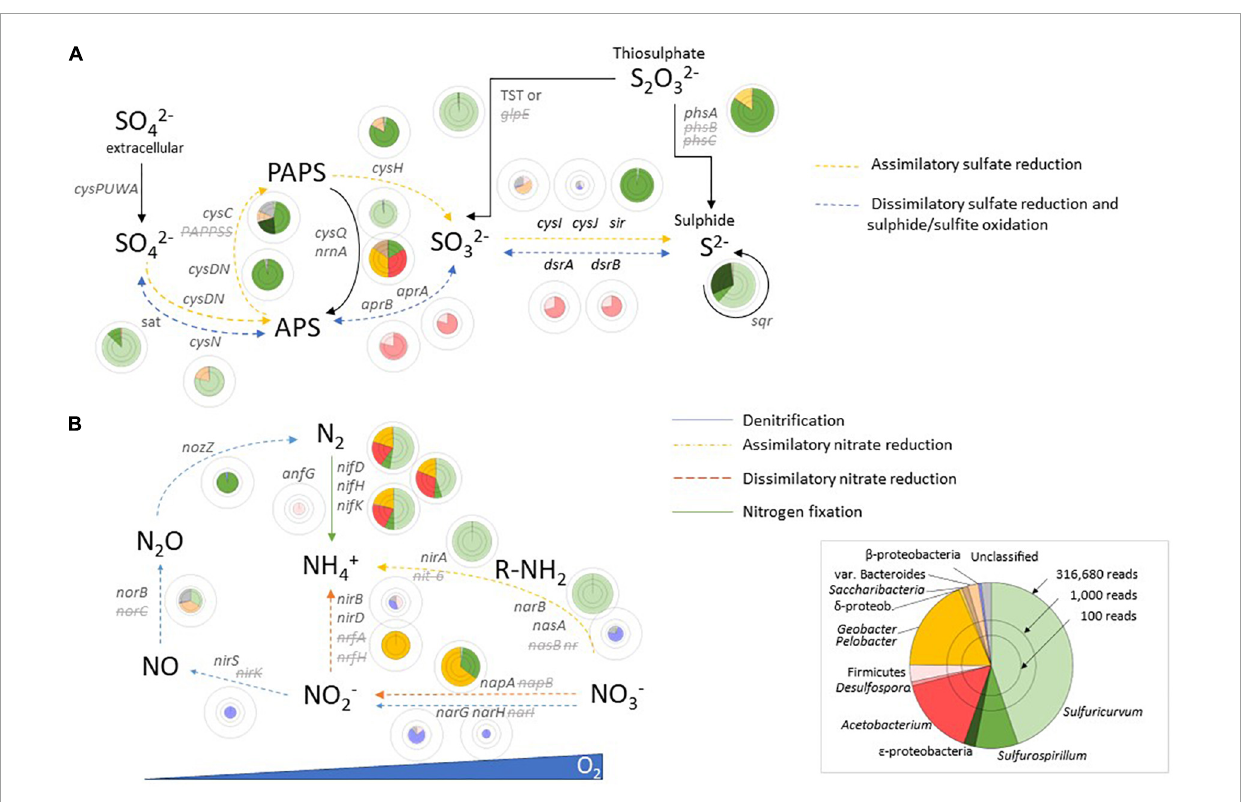
FIGURE3 Sulphur metabolism (A) and nitrogen metabolism (B) in East Skaftárkatlar lake. APS, adenosine-5-phosphosulfate; PAPS, 3-phospho adenosine-5-phosphosulfate; PEP,